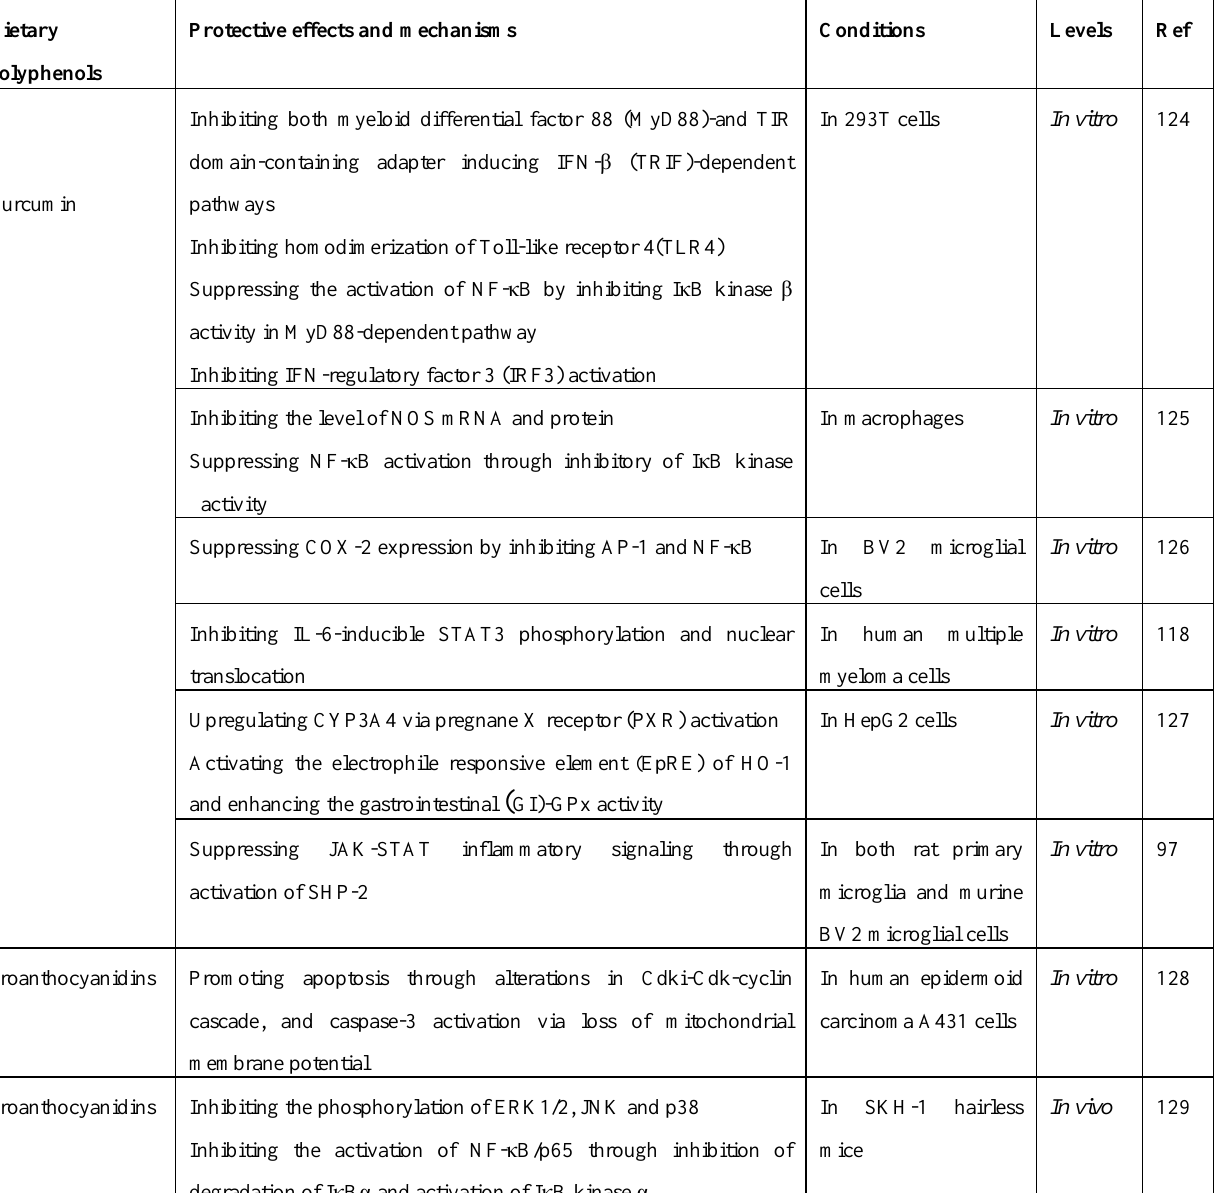
Table 7. Effects of dietary polyphenols on signal transduction